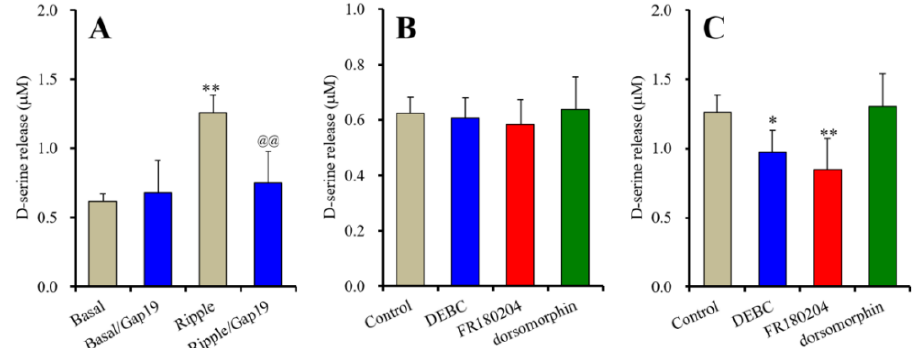
Figure 1. Effects of 10 µ M TAT-conjugated Gap19 (Gap19), connexin43 (Cx43) inhibitor, on acute artificial ripple-burst evoked astroglial D-serine release ( A ), effects of intracellular signalling inhibitors on basal ( B ) and ripple-evoked astroglial D-serine releases ( C ). In Panel A, during ripple-evoked stimulation (100 sets), the cultured astrocytes were incubated in artificial cerebrospinal fluid (ACSF) with or without (control) 10 µ M Gap19. In Panel B: the cultured astrocytes were subchronically (for 7 days) administrated by intracellular signalling inhibitors, protein kinase B (Akt) inhibitor, 10-[4-(N,N-diethylamino)butyl]-2-chlorophenoxazine hydrochloride (DEBC: 10 µ M), extracellular signal-regulated kinase (Erk) inhibitor, 5-(2-Phenyl-pyrazolo[1,5-a]pyridin-3-yl)-1H-pyrazolo[3,4-c] pyridazin-3-ylamine (FR180204: 20 µ M) and adenosine monophosphate-activated protein kinase (AMPK) inhibitor (dorsomorphin: 10 µ M). In Panel C: after subchronic applications of 10 µ M DEBC, 20 µ M FR180204 or 10 µ M dorsomorphin, the cultured astrocytes were stimulated by ripple-burst evoked stimulation (100 sets). Ordinates indicate the mean ± standard deviation (SD) of extracellular D-serine level ( µ M) ( n = 6). * p < 0.05, ** p < 0.01; relative to control, @@ p < 0.01; relative to ripple-burst evoked release (Gap19 free) by one-way analysis of variance (ANOVA) with Tukey’s post-hoc test. An Akt inhibitor, 10-[4-(N,N-diethylamino)butyl]-2-chlorophenoxazine hydrochloride (DEBC: 10 µ M), Erk inhibitor, 5-(2-Phenyl-pyrazolo[1,5-a]pyridin-3-yl)-1H-pyrazolo[3,4-c] pyridazin-3-ylamine (FR180204: 20 µ M) [18,31,39,40,52] and AMPK inhibitor, dorsomor- phin (10 µ M) [54], also did not affect basal astroglial D-serine release (Figure 1B),